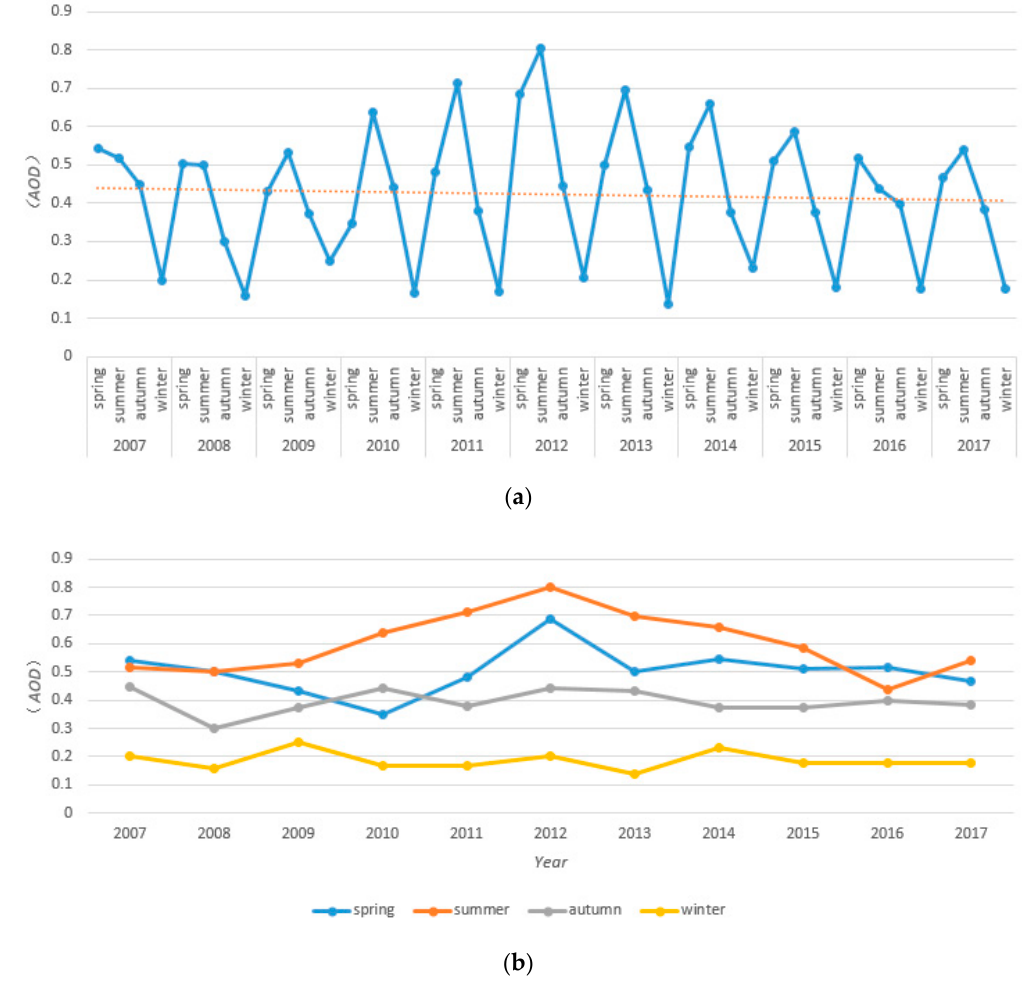
Figure 8. Quarterly data chart. ( a ) AOD overall trend chart, ( b ) Quarterly trend chart.